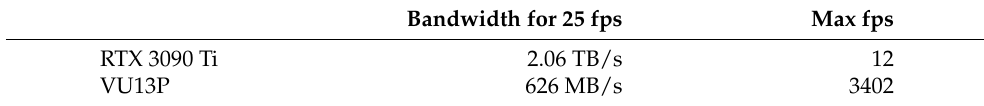
Table 6. Bandwidth of a 25-fps video and maximum achievable fps with the MR